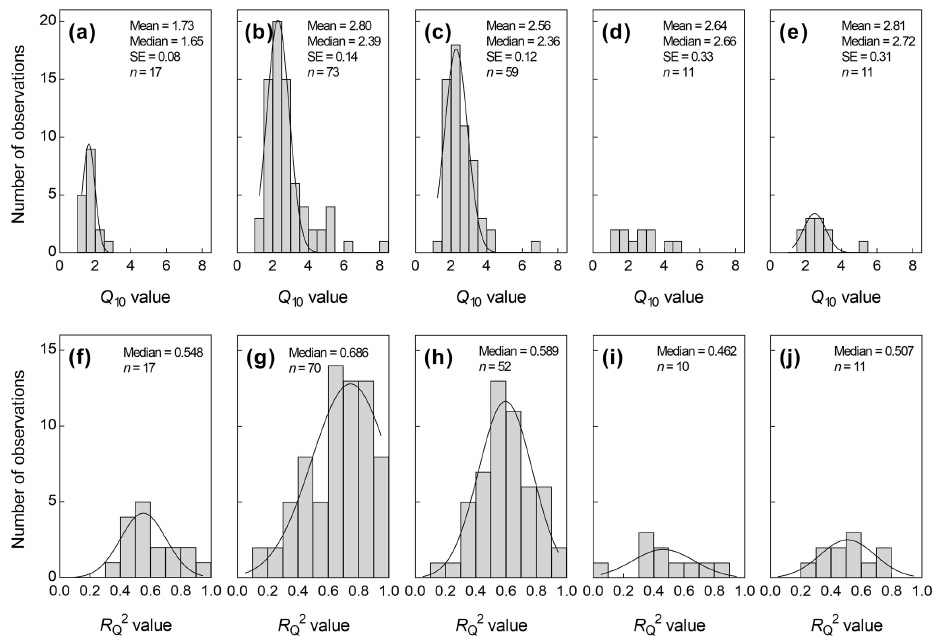
Figure 3. Histogram plots for Q 10 values (a–e) and the coefficient of determination for Q 10 ( R 2 surface temperature; (b, g) soil temperature at a depth of 5cm; (c, h) soil temperature at a depth of 10cm; (d, i) soil temperature at a depth of 15cm; (e, j) soil temperature at a depth of 20cm. n represents the number of